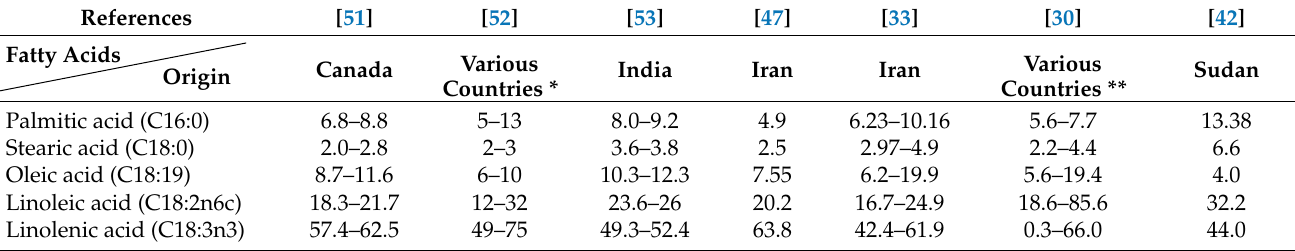
Table 4. Fatty acid composition (g/100 g) of basil